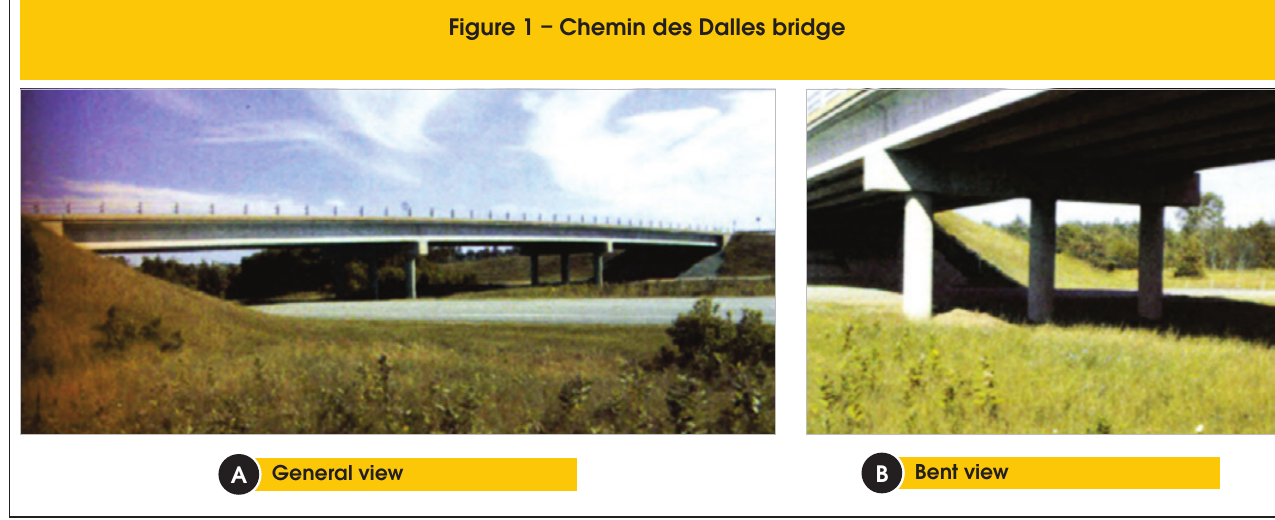
Figure 1 – Chemin des Dalles